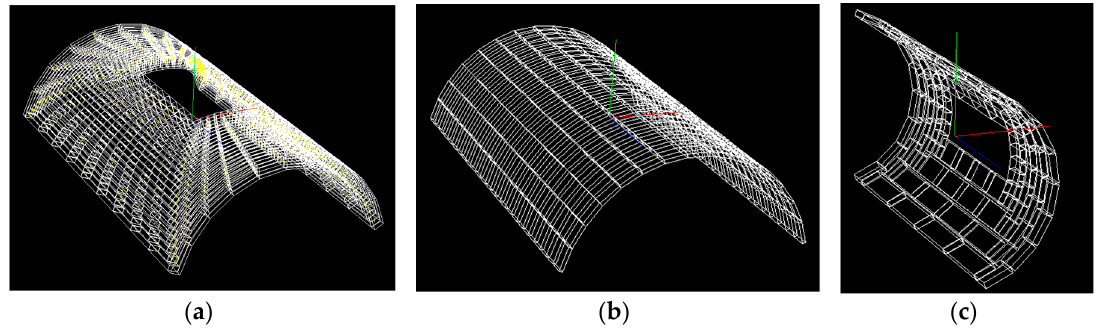
Figure 10. Screenshots of a the active parts of the compulsator: ( a ) field coil (stationary inner part); ( b ) compensating shield (stationary part just outside the field coils); ( c ) rotating armature (outer part). At the instant of firing the magnetic axis of the field and of the armature coils are aligned, while